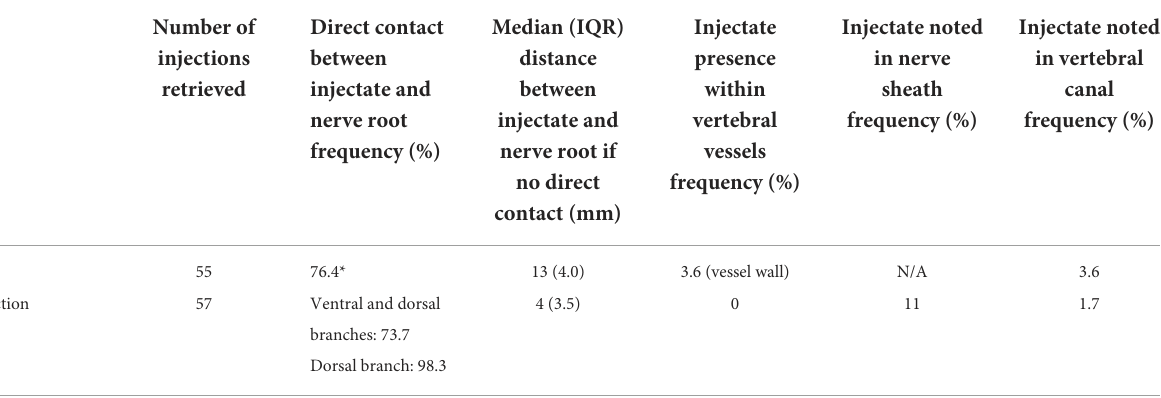
TABLE 1 Cervical nerve root injection findings based on CT and